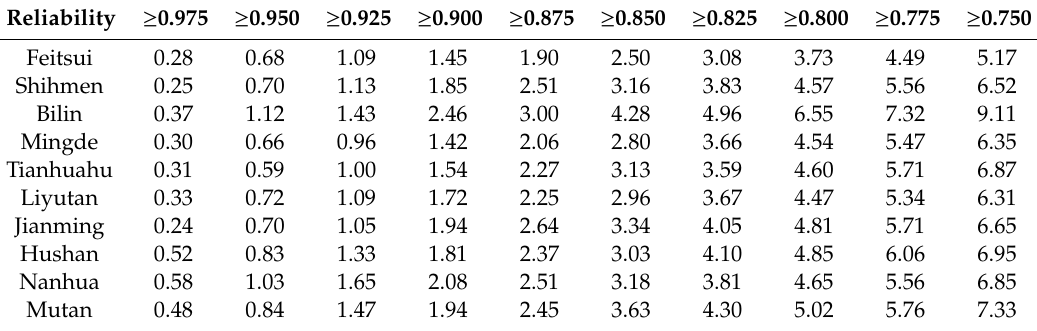
Table 7. The corresponding GSI of maximum water supply amount for all reservoirs.